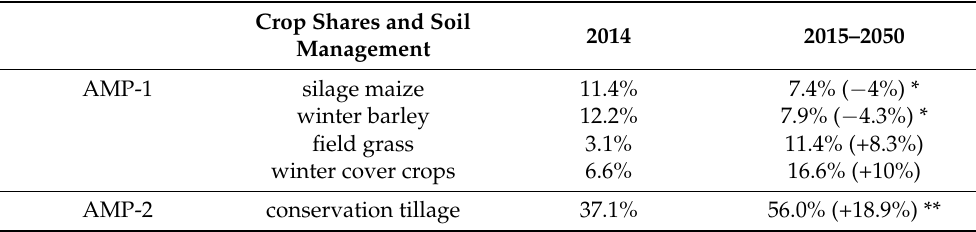
Table 1. Parameterization of the alternative management practice (AMP) scenarios summarized on the level of Saxony